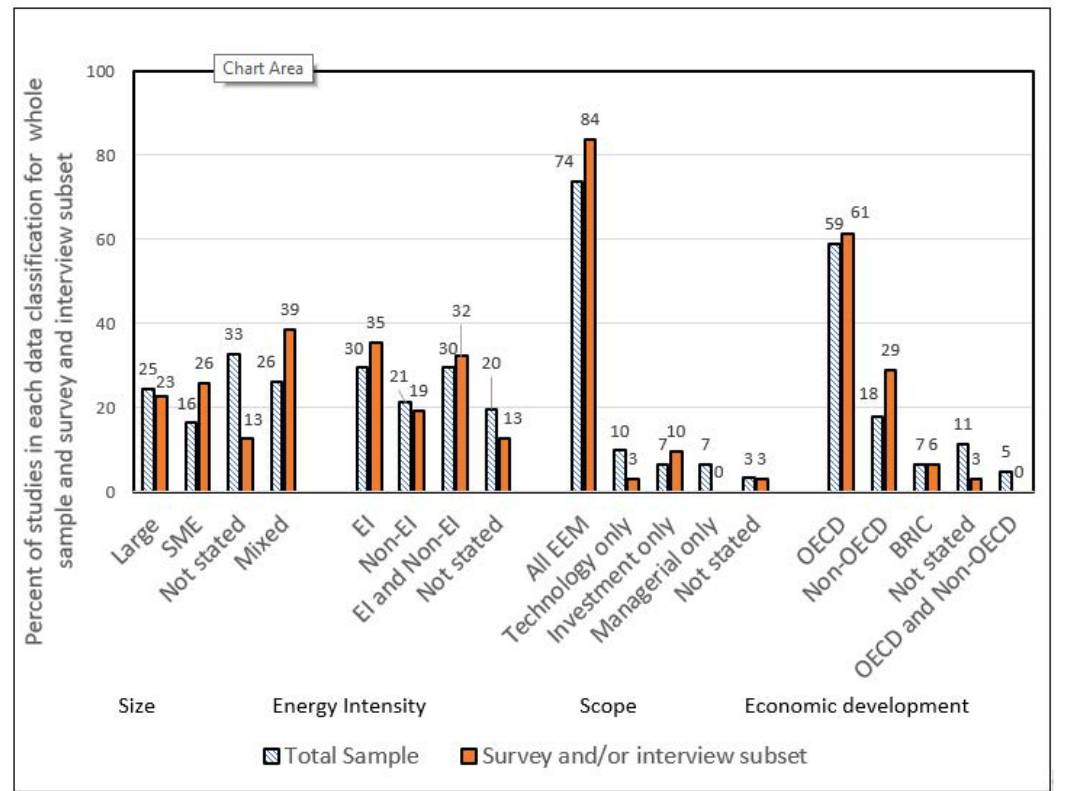
Figure 2. Comparison of whole sample and subset of data from interviews in percent, classified by size (large, small to medium (SME), not stated and mixed), energy intensity (energy-intensive (EI), non-energy-intensive (Non-EI), EI and non-EI and not stated), study scope (All energy efficiency measures (All EEM), technology only, investment only, managerial only and not stated) and economic development (not stated, OECD and Non-OECD, OECD, non-OECD and Brazil, Russia, India, China (BRIC)).